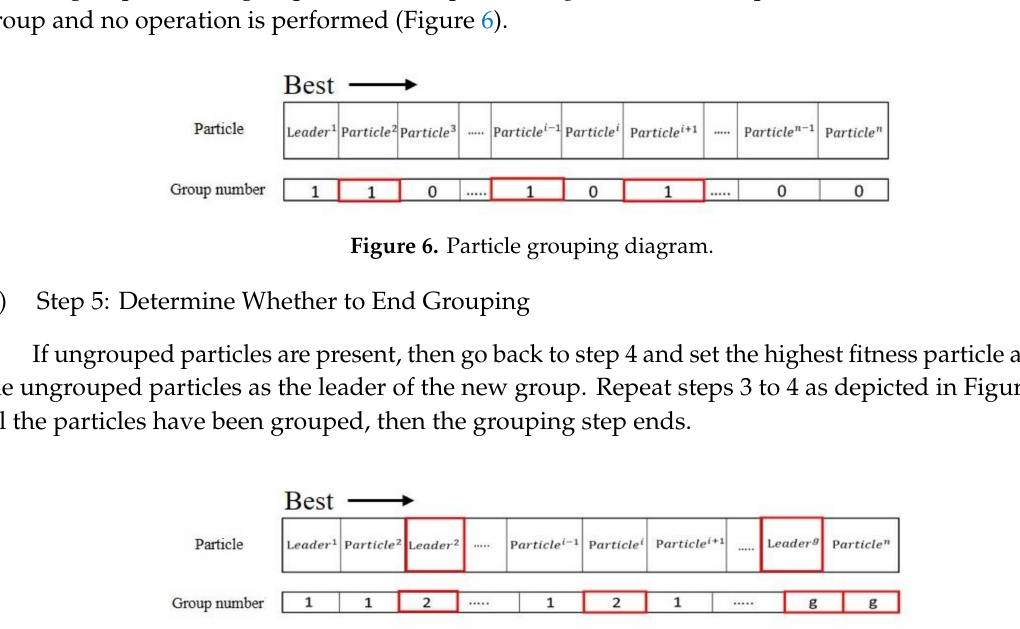
Figure 7. Repeat steps 3 to 4 diagram.